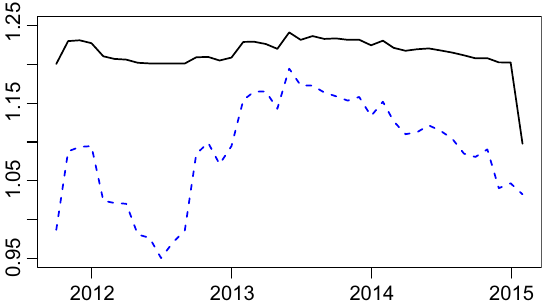
Fig. 2 EUR/CHF observed (black) and latent exchange rate (blue, calculated following Hanke et al., 2019), monthly averages.